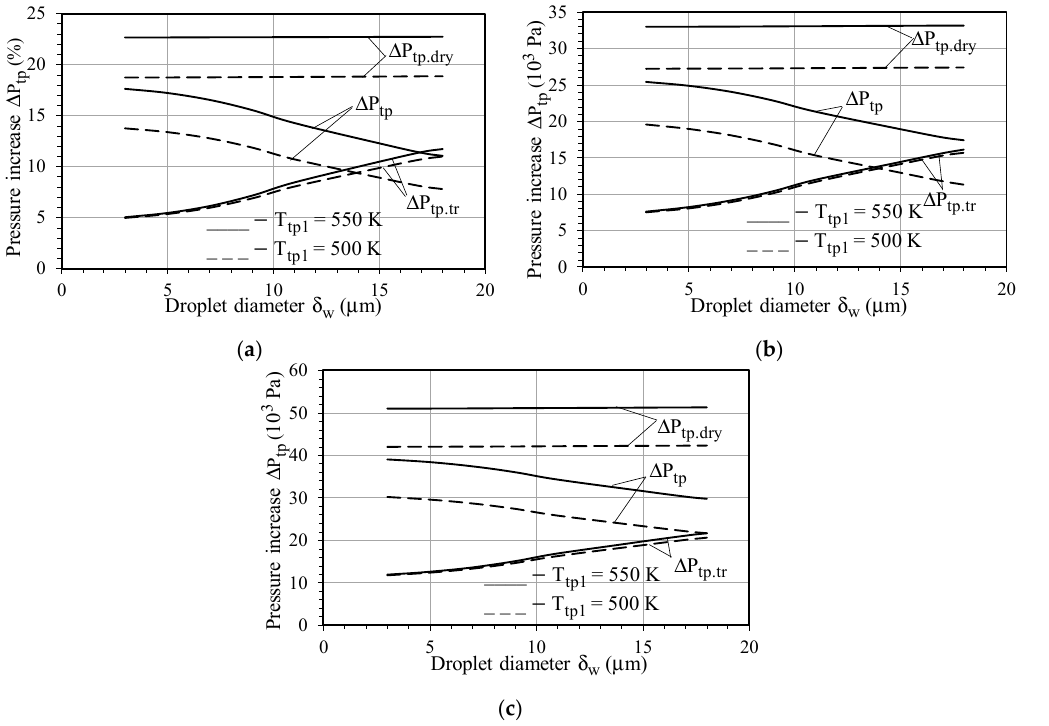
Figure 7. Dependences of the absolute pressure increase, P tp = P tp2 – P tp1 , on the droplet diameter, δ w , at different air temperatures and Mach numbers at the inlet: ( a ) Ma = 0.50, ( b ) Ma = 0.60 and ( c ) Ma = 0.74.